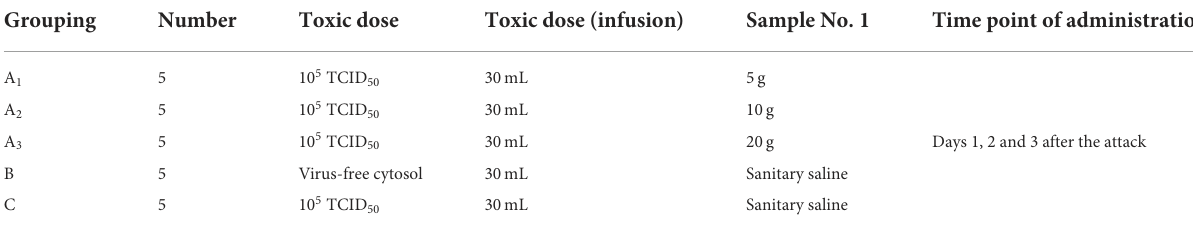
TABLE 1 Information on piglet grouping, attack and dosing.